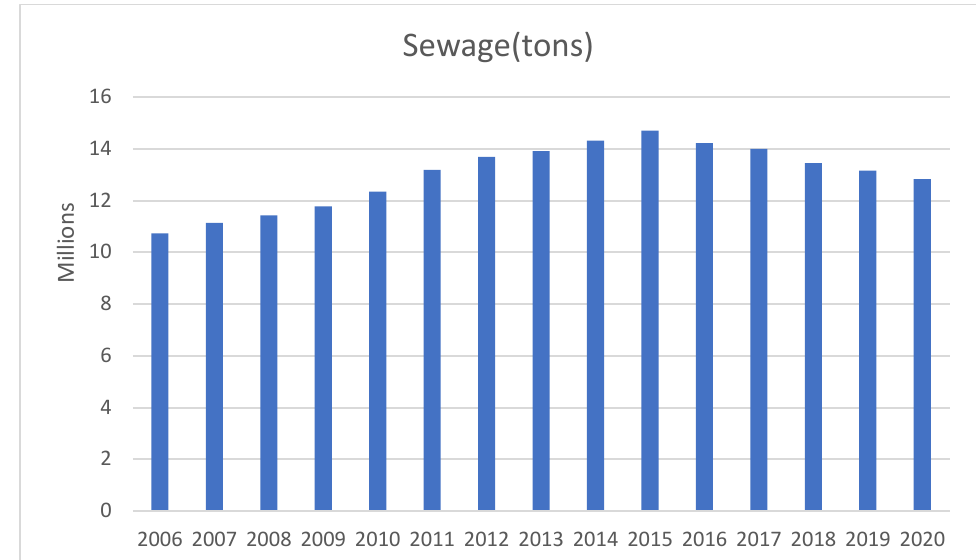
Figure 2. Total sewage in 31 provinces of China.